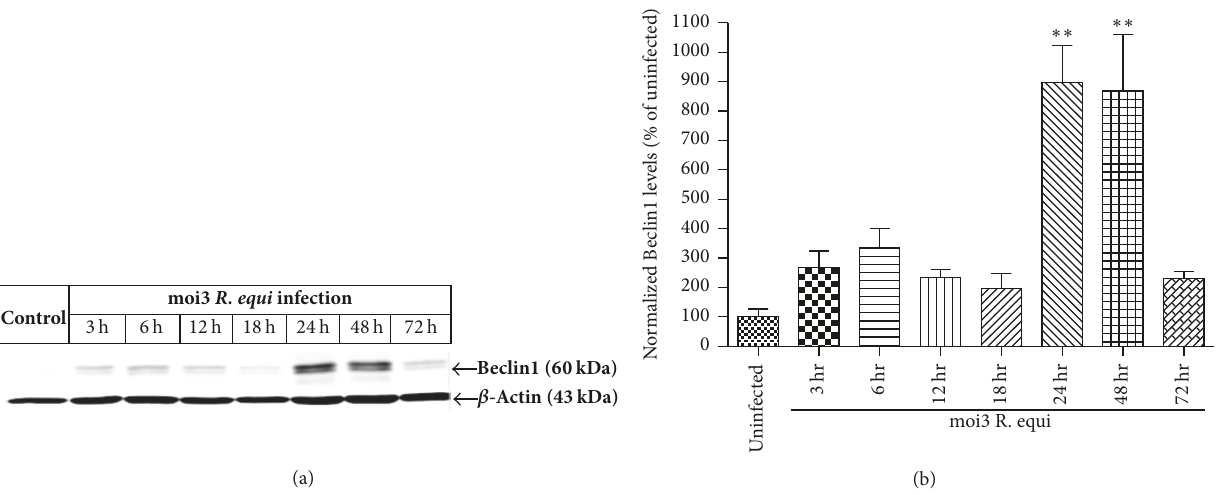
Figure 4: Western blotting analysis showing the expression of Beclin1 levels in the whole cell protein lysates of BMDM infected with R. equi (moi3). (a) Beclin1 expression was observed at 24 h and 48 h. Uninfected BMDM were considered as control. 𝛽 -Actin immunoblot represents equal protein loading. (b) Densitometry analysis was used to quantify the density of Beclin1 bands. The ratio of Beclin1 bands to that of 𝛽 -actin was determined and the data are expressed as percent of control. Data represent mean ± SEM, ∗∗ 𝑝 < 0.01